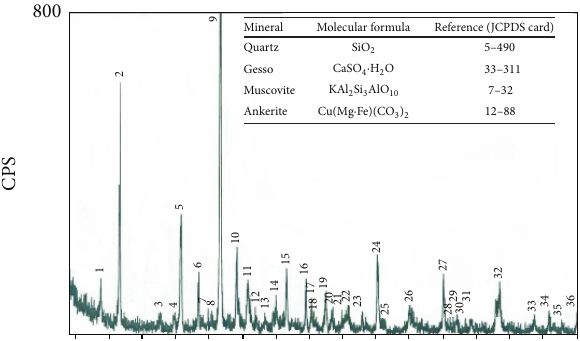
Figure 11: X-ray diffraction of neutralization